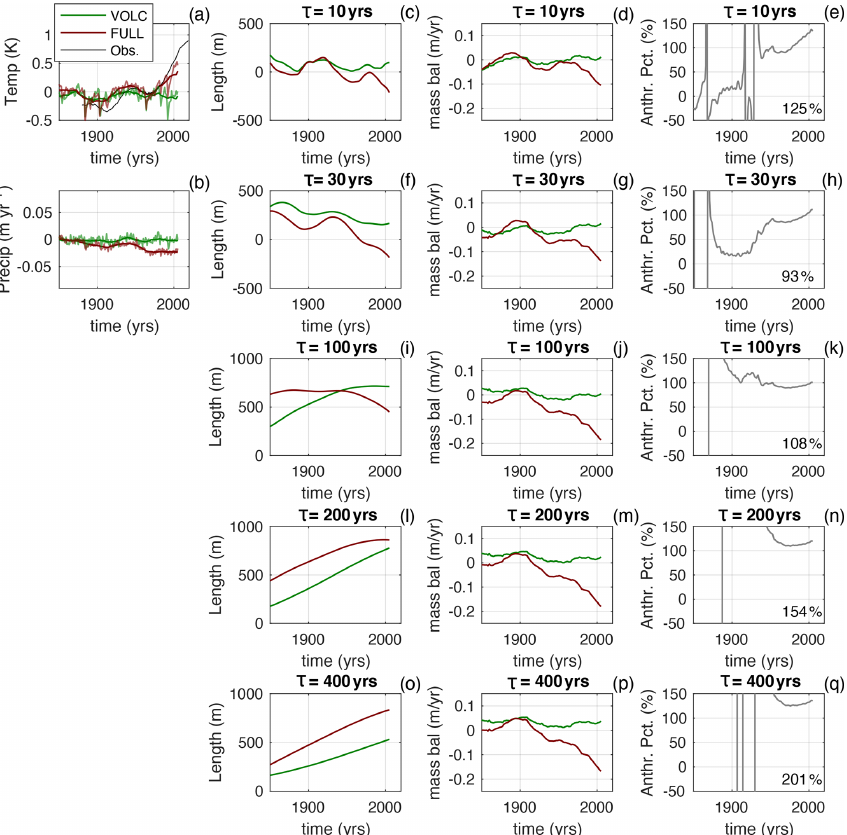
Figure 8. Same as Fig. 7 but zoomed in to the 1850 to 2005 interval. The percentages inserted into the right-hand columns give the anthro- pogenic cumulative mass loss relative to the total cumulative mass loss between 1880 and 2020. Note these cumulative percentages will not, in general, be equal to the time average of F anth